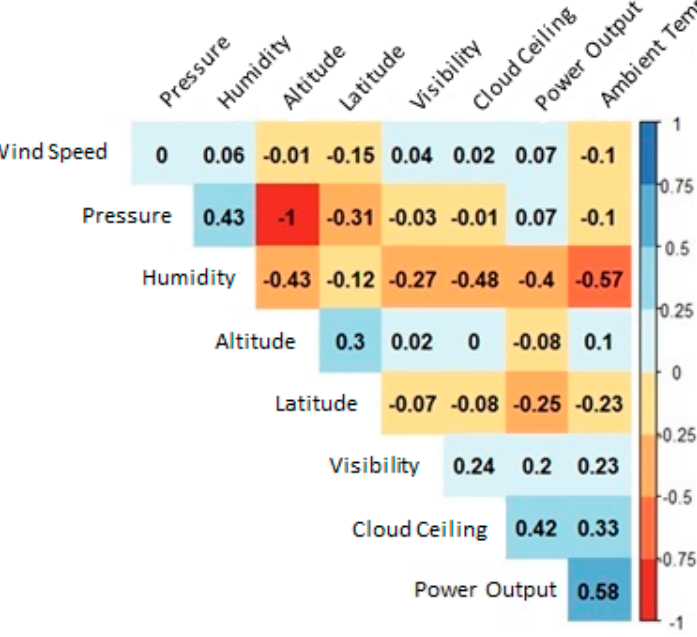
Figure 2. Correlation coefficients for numeric variables.